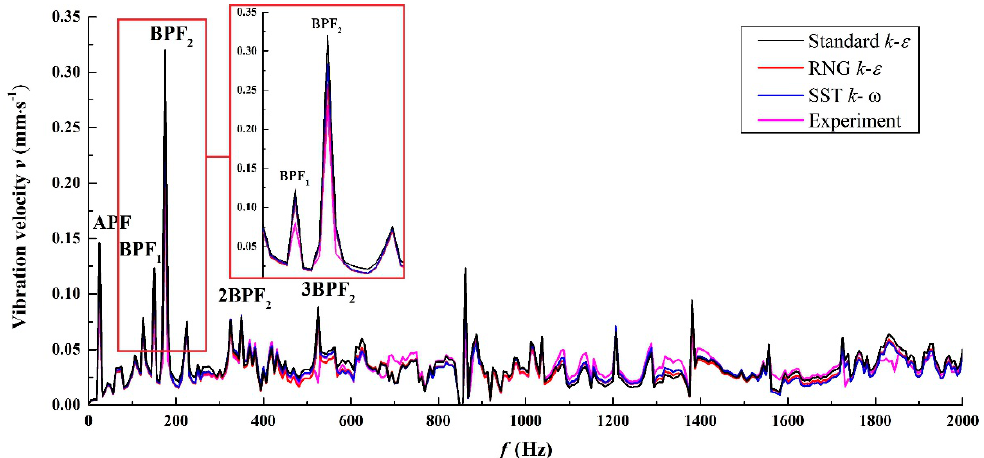
Figure 12. Vibration comparison between simulation and experiment. APF, axial passing frequency; BPF 1 , first blade passing frequency; BPF 2 , secondary blade passing frequency.